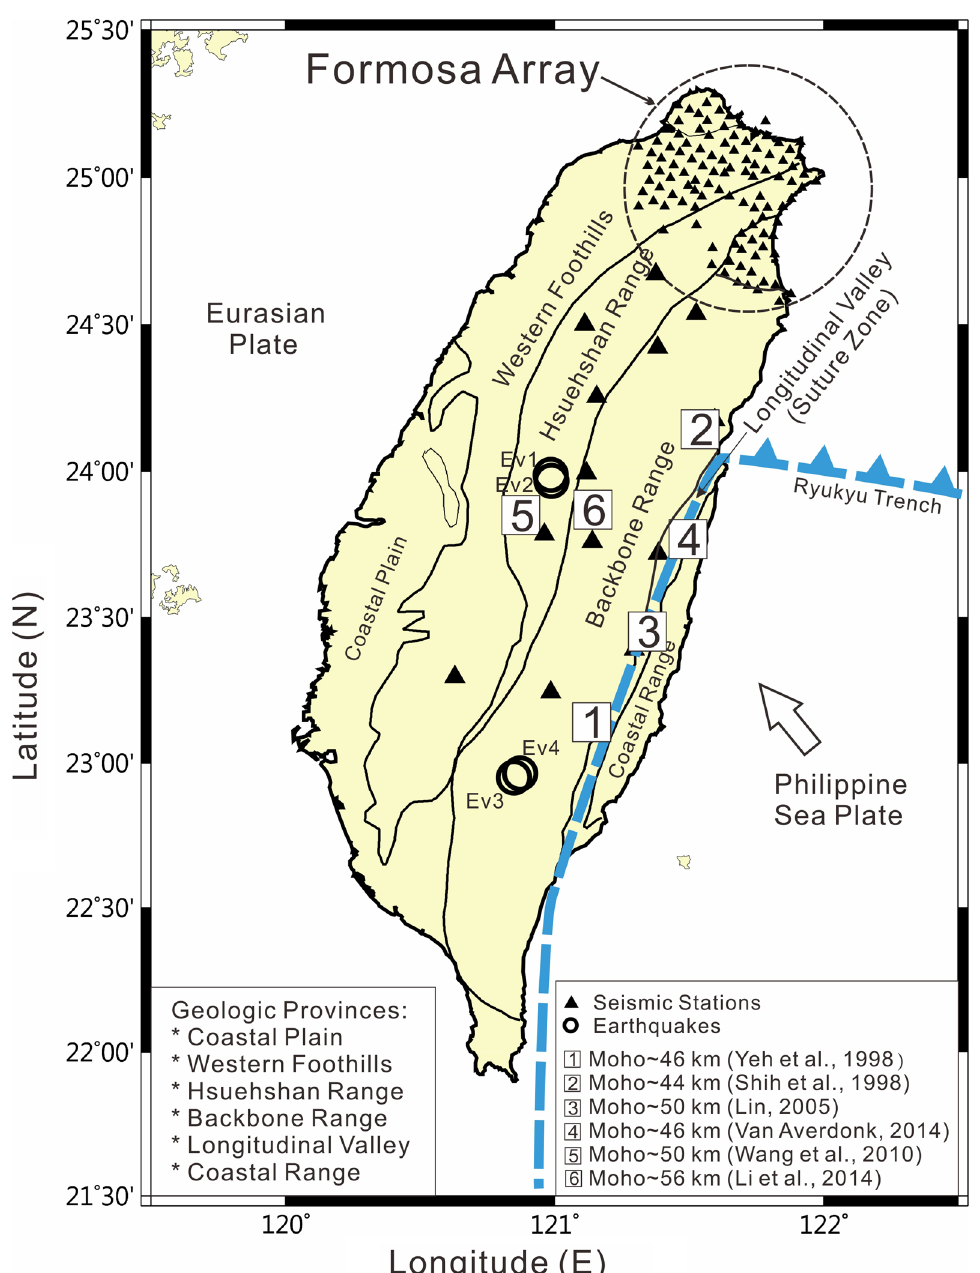
Fig. 2 Geologic provinces and locations of both the Formosa Array and some Broadband Array in Taiwan for Seismology (BATS) seismic stations in the mountainous area of Taiwan. Locations of the deepest crustal thickness are marked by Number 1–6 within squares, which were obtained